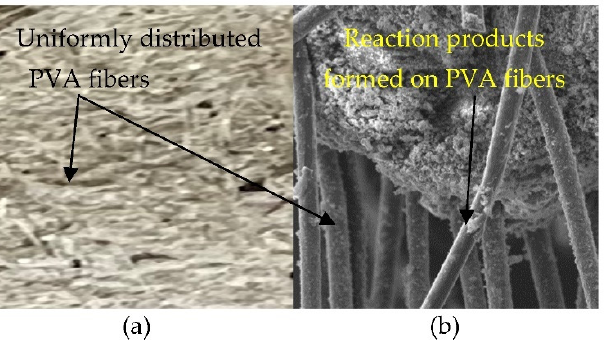
Figure 12. ( a ) Fracture surface showing uniformly distributed PVA fibers in the matrix. ( b ) Reaction products formed on the PVA fibers.